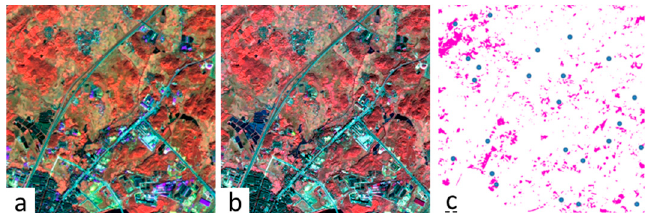
Remote Sens. 2017 , 9 , 19